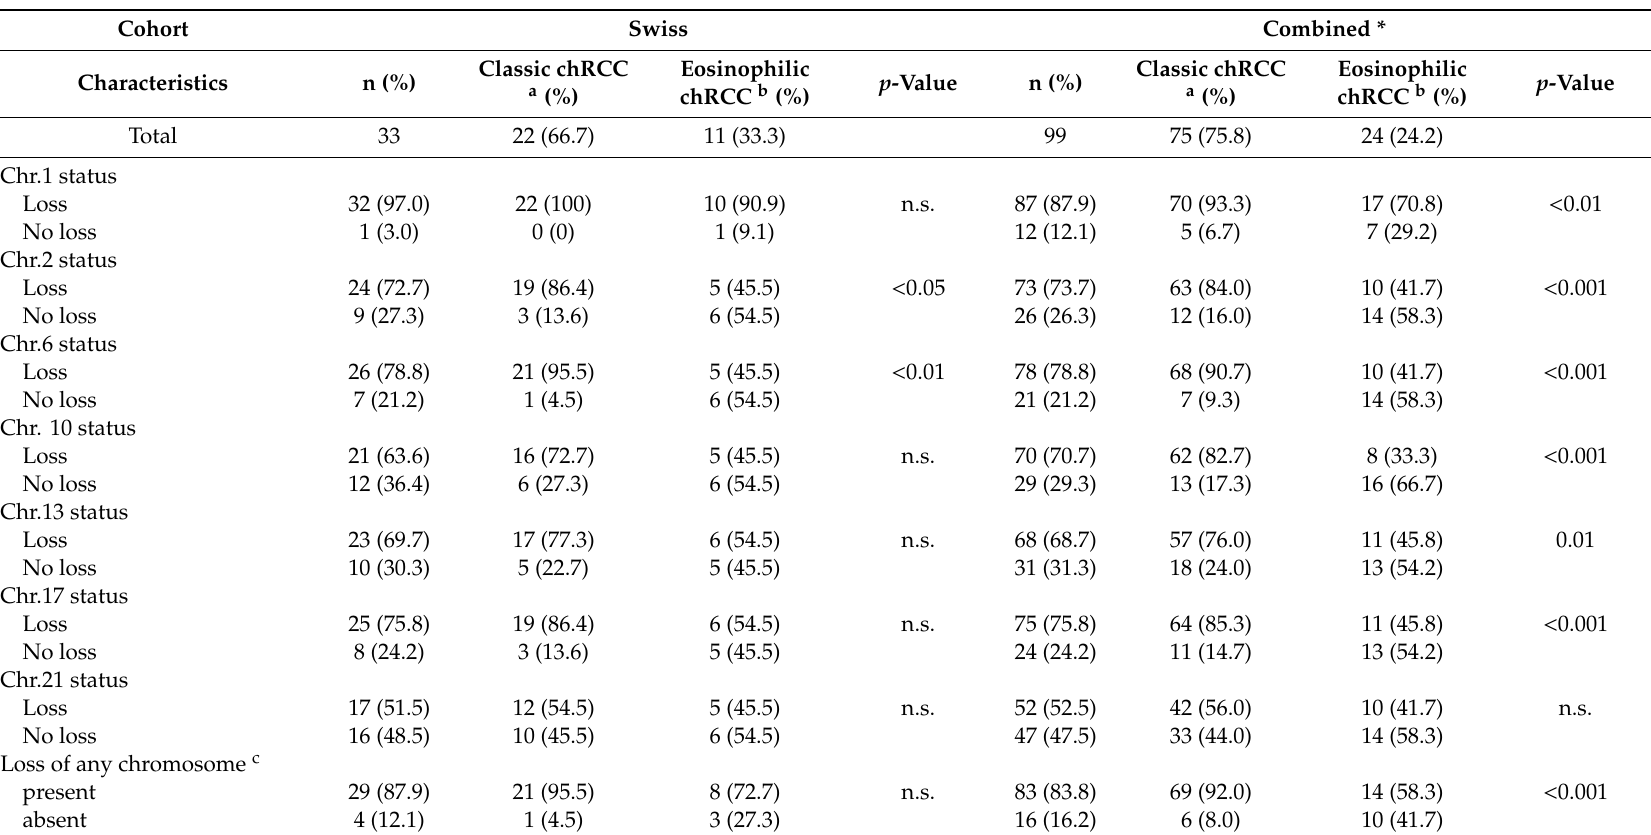
Table 2. Copy number variation (chromosomal losses) in classic and eosinophilic chromophobe renal cell carcinomas (chRCCs) (Chr. = chromosome) from 33